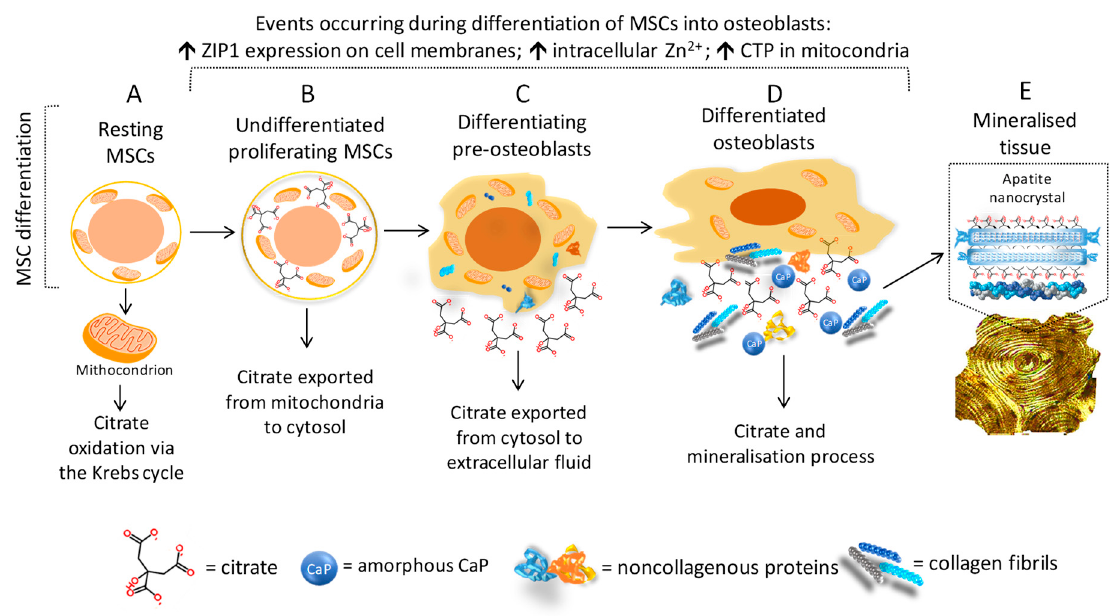
Figure 4. Citrate metabolism, osteoblast di ff erentiation, and mineralisation process. The figure combines the concept of “osteoblast citration” with the main steps of the di ff erentiation of mesenchymal stem cells (MSCs) into bone-forming cells (osteoblasts) [5,53,56]. ( A ) Resting MSCs are quiescent, nonproliferating cells which exhibit the typical mitochondrial metabolism with the oxidation of citrate via the Krebs cycle. ( B ) In the presence of proper stimuli, the undi ff erentiated MSCs are committed to osteogenic di ff erentiation and, at the early phase, high proliferation is required. To accomplish this goal, the following events are necessary: (1) the upregulation of ZIP1 which promotes the zinc intake, (2) the accumulation of mitochondrial citrate due to the zinc-dependent inhibition of the mitochondrial aconitase, (3) the exportation of citrate into cytosol by means of the “citrate transport protein” (CTP / SLC25A1), (4) the use of cytosol citrate for the lipogenesis process which is essential for cell duplication. ( C , D ) The citrate exportation from cytosol to extracellular fluid starts during cell di ff erentiation, and it is simultaneous for the synthesis and the release of amorphous CaP, collagen, and noncollagenous proteins. ( E ) The “osteoblast citration” is completed when the mineralised matrix is assembled. The role of citrate in growing the apatite nanocrystals and driving the mineralisation process is explained in Figure 3.